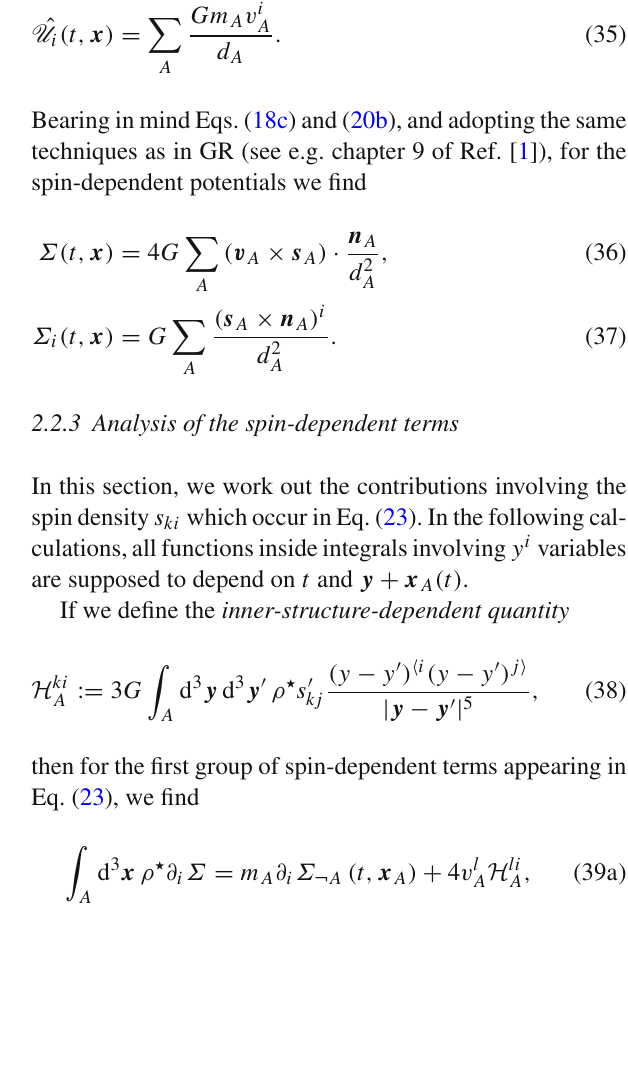
value of the spin density tensor of each fluid element, which contains a set of microscopic spin configurations, is assigned via an average procedure. Each fluid element is spinning uniformly without changing